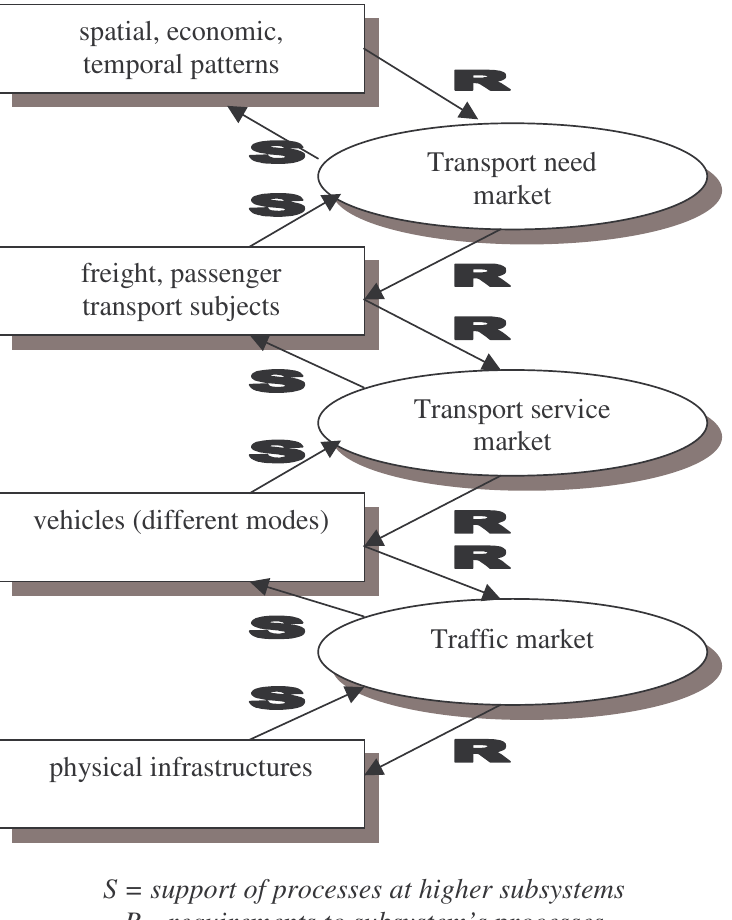
Figure 1. Structure of the transport